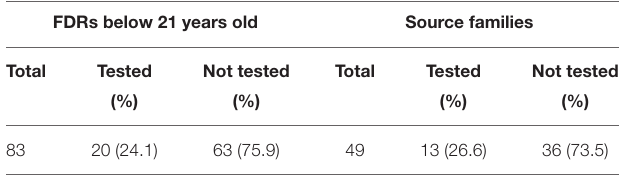
TABLE 1 | Proportion of FDRs below 21 years old and families who had predictive testing. FDRs below 21 years old